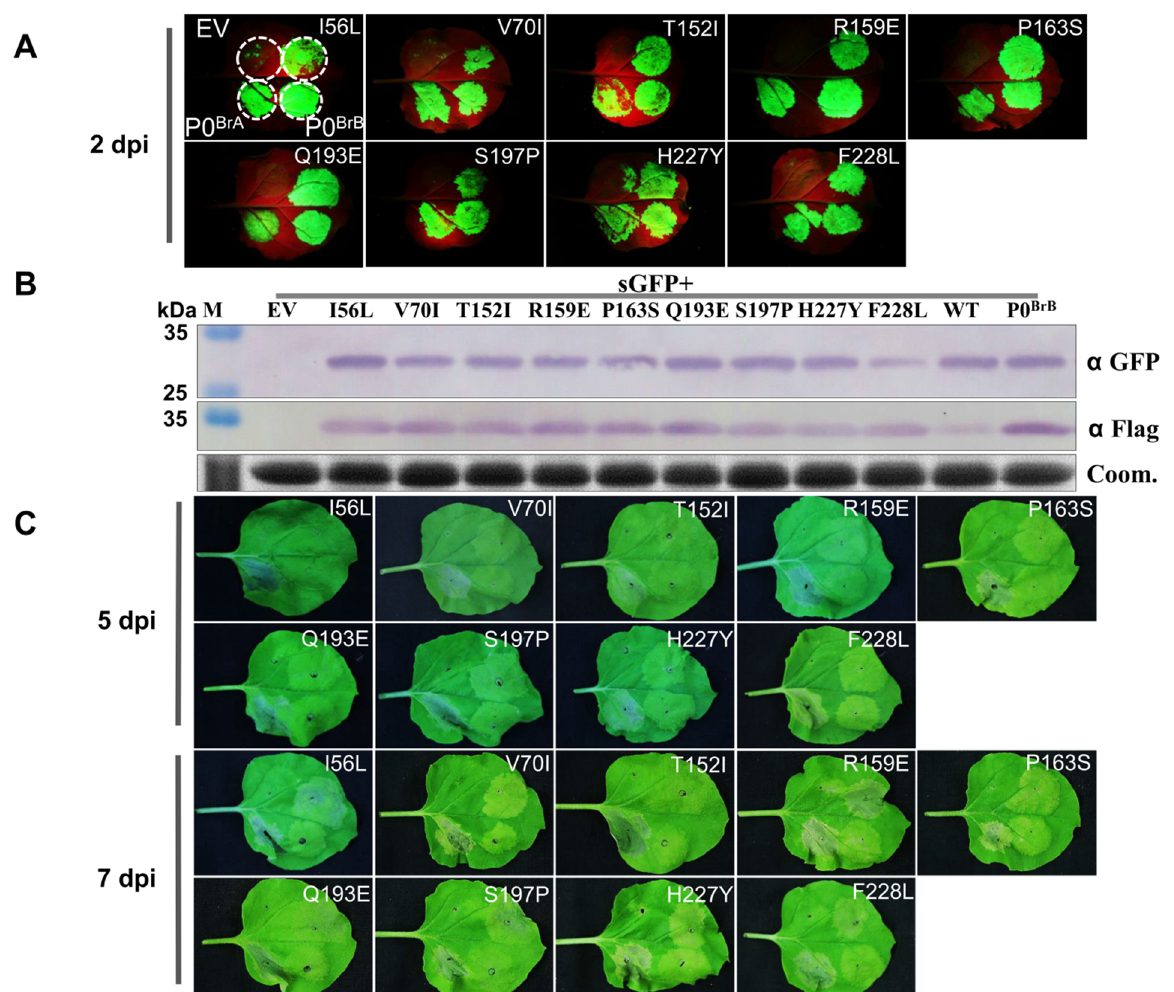
Figure 4. Suppression of local RNA silencing by P0 BrA mutants. ( A ) Agroinfiltration with GFP plus empty vector pGD (EV), P0 BrA , P0 BrA mutants, or P0 BrB in N. benthamiana leaves. ( B ) Western blot analysis of GFP and P0 BrA mutants in N. benthamiana -infiltrated patches from ( A ). ( B ) GFP and P0 BrA mutants were detected using an antibody specific for GFP and Flag, respectively. Coomassie-stained (Coom.) gels are the loading control. Molecular weights of protein marker (M) are shown on the left. ( C ) Cell death phenotypes in N. benthamiana leaves with transiently-expressed P0 BrA or its mutants. Photographs were taken under white light to show cell death at 5 or 7 dpi. Empty vector (EV) was used as the negative control.